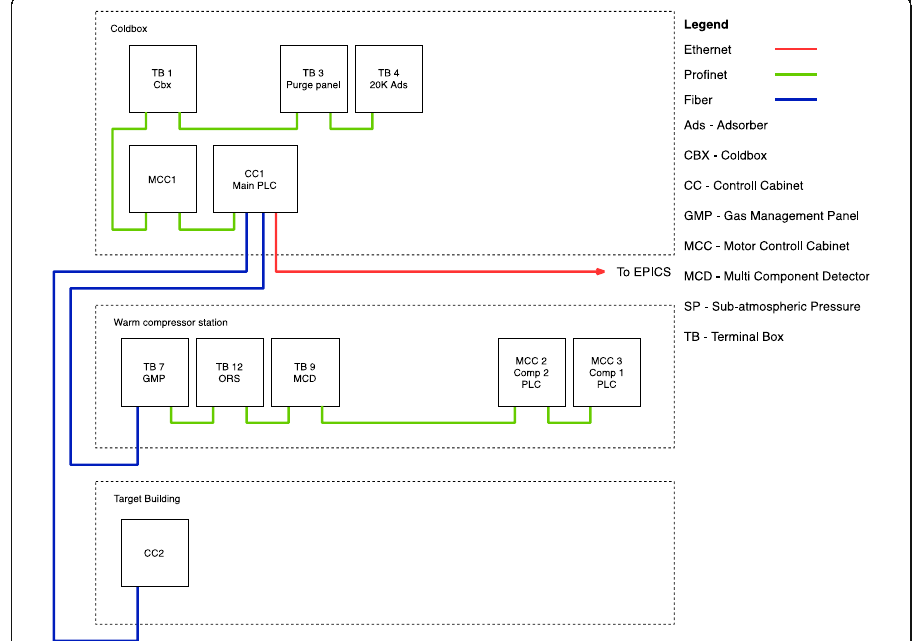
Fig. 11 Simplified control systems architecture